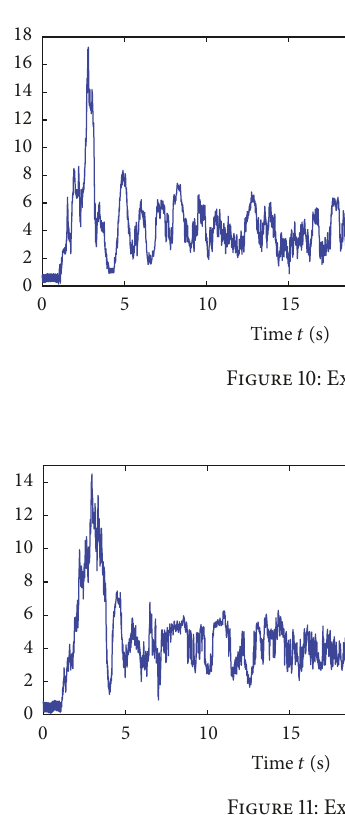
Figure 11: Experiment result of robotic machining under fuzzy-PID control.